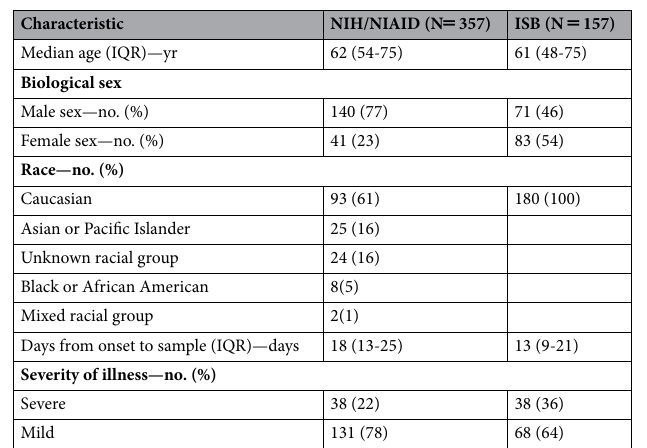
Table 1. Demographic data of the ImmuneCODE database. Demographic data for ImmuneCODE database were collected including biological sex, age, and racial group. Additionally shown, time between symptom onset and sampling along with proportion of individuals with severe illness; documented with either ICU admission or WHO ordinal scale > 4 (corresponding to individuals requiring critical care